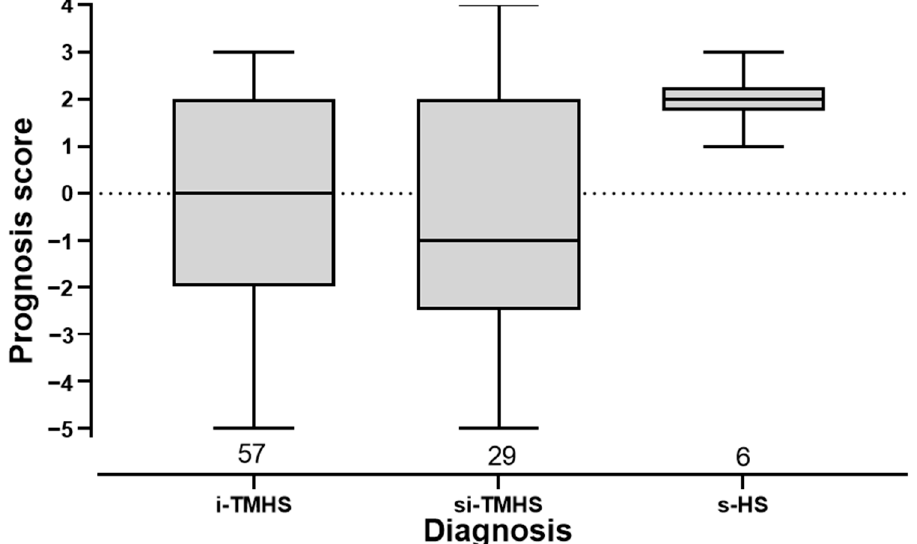
Figure 4. Prognosis score for different diagnoses is shown in boxplots. There were no significant differences between the different diagnoses (Kruskal–Wallis rank-sum test, p > 0.05). The prognosis score represents the general outcome incorporating the outcome of clinical signs, outcome of equestrian use, and responsiveness to therapy. Scores are negative for deterioration and positive for improvement (Table S2). Horses without evaluable outcome were excluded. i-TMHS: idiopathic trigeminal-mediated headshaking, si-TMHS: suspected idiopathic trigeminal-mediated headshaking, s-HS: secondary headshaking .